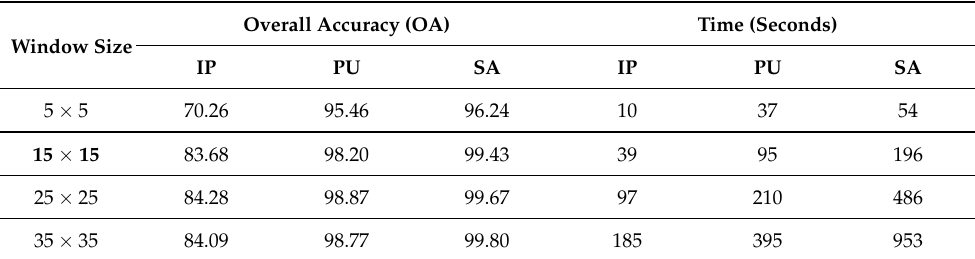
Table 3. The impact of window size on the overall accuracy and testing time of C-CNN-Aug, where λ = 0 . 10